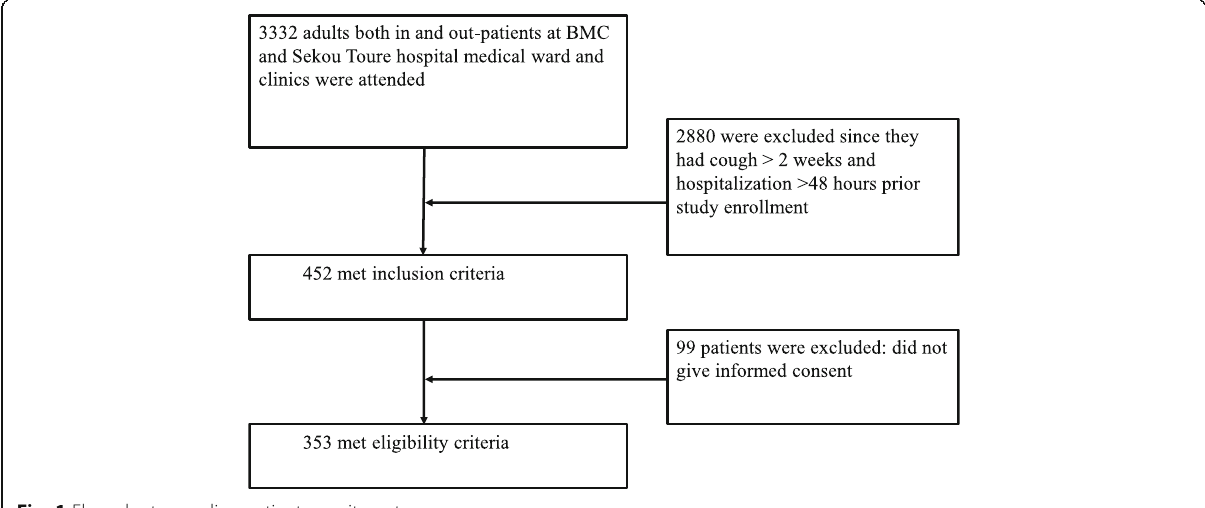
Fig. 1 Flow chart regarding patient